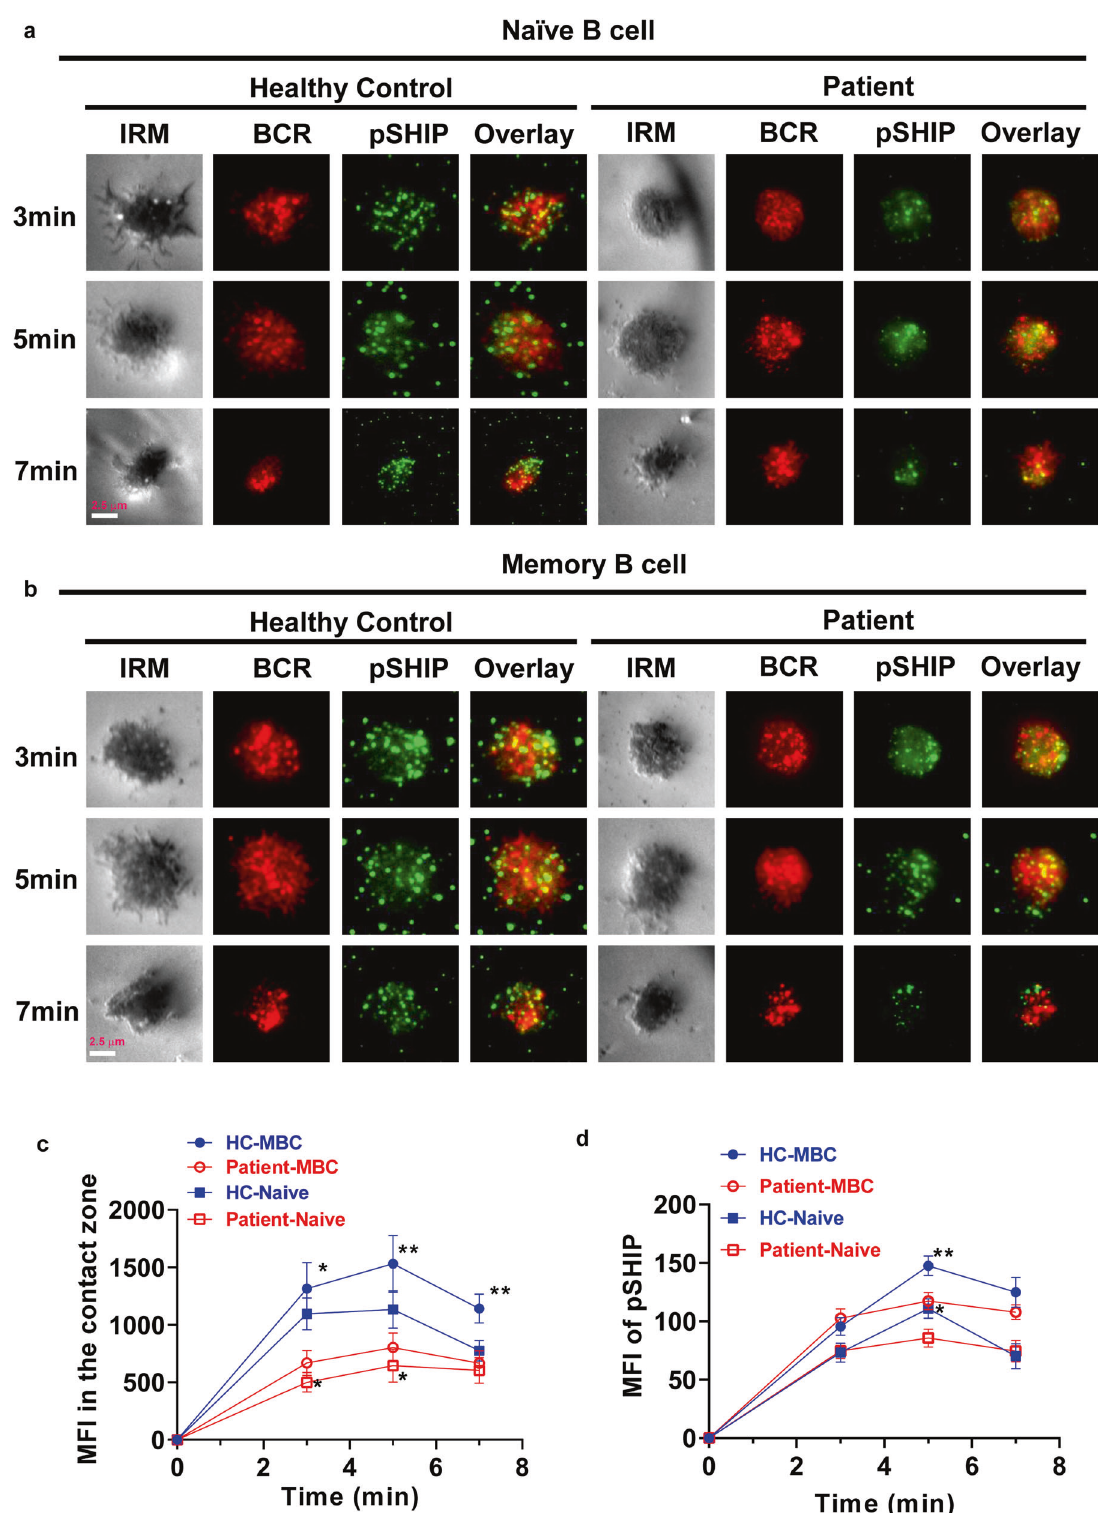
Fig. 5 SARS-CoV-2 infection inhibits the early activation of SHIP in B cells. Naive (CD27 − ) and memory (CD27 + ) B cells from COVID-19 recovered patients and healthy controls were activated with 10 µg/ml AF546 – mB-Fab ′ – anti-Ig tethered to lipid bilayers at 37 °C for 3, 5 and 7 min. Then cells were fi xed, permeabilized, and stained with Alexa Fluor 647 anti-CD27 and anti-pSHIP ( a , b ), followed by Alexa Fluor 488 goat anti-rabbit IgG. Cells were analyzed by Tirf microscope. Shown are representative images, and the MFI of BCR ( c ) and pSHIP ( d ) in the contact zone from three independent experiments. Scale bars, 2.5 μ m. Statistical evaluation was performed using the two-tailed Student ’ s t -test. Statistical signi fi cance is indicated using asterisks: * p < 0.05, ** p < 0.01, *** p < 0.001, and **** p < 0.0001